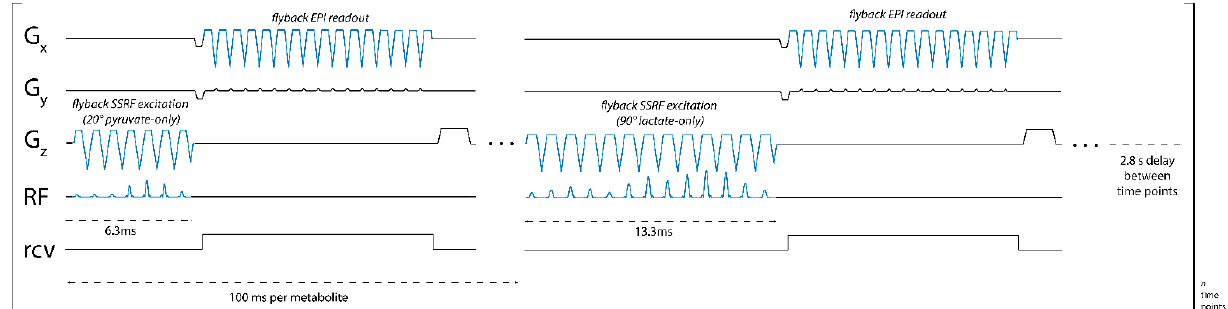
Figure 1. Pulse sequence diagram for metabolite ‐ specific 2D EPI imaging of [1 ‐ 13 C]pyruvate and [1 ‐ 13 C]lactate at 4.7 T. An image of both pyruvate and lactate was acquired every 2.8 s, with a 100 ms acquisition time for each image.